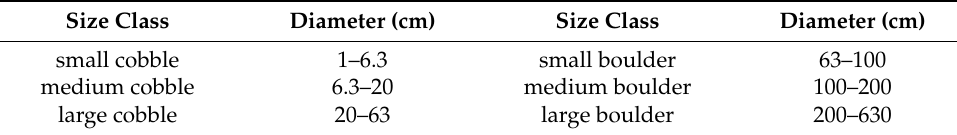
Table 2. Size Classification According to the Kolp